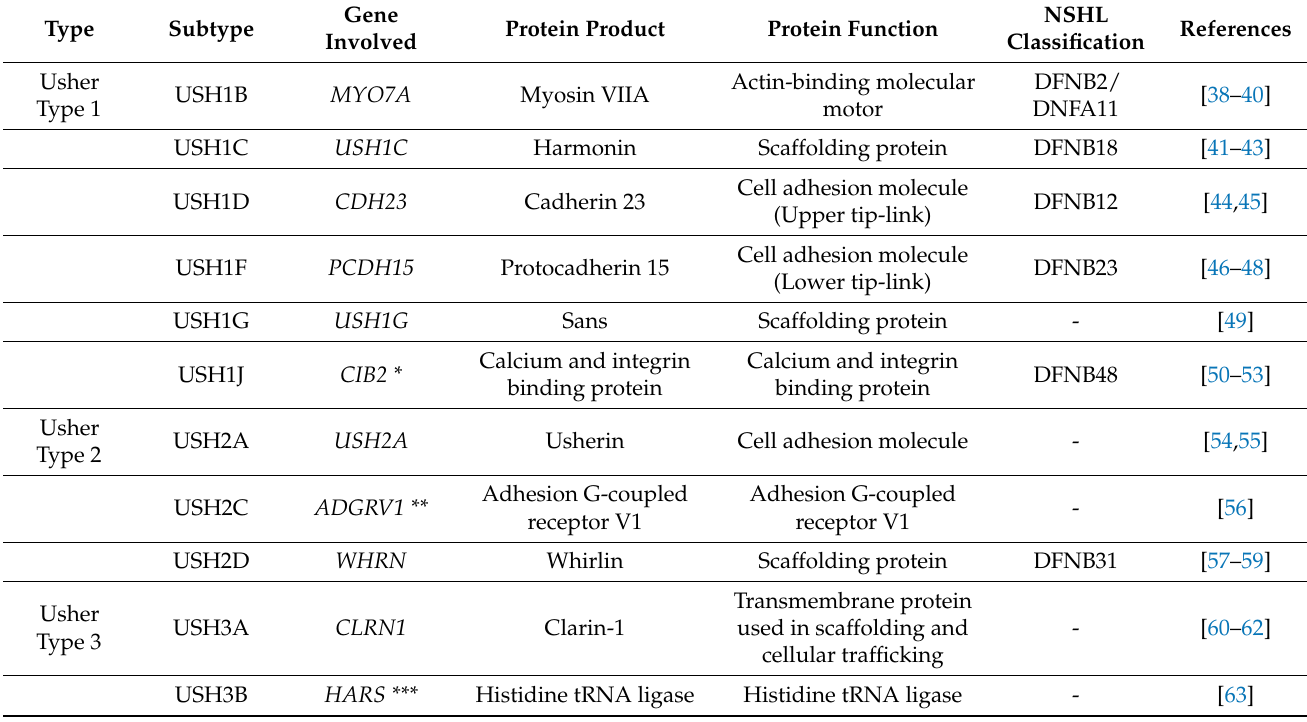
Table 1. Usher type, subtype, and associated